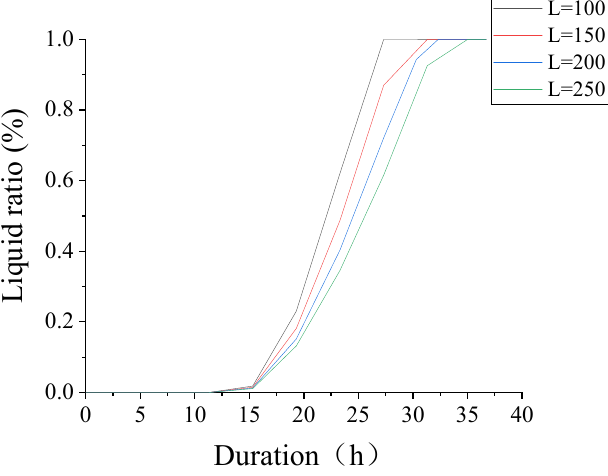
Figure 11. Effect of latent heat on the melting rate of the heat storage module.